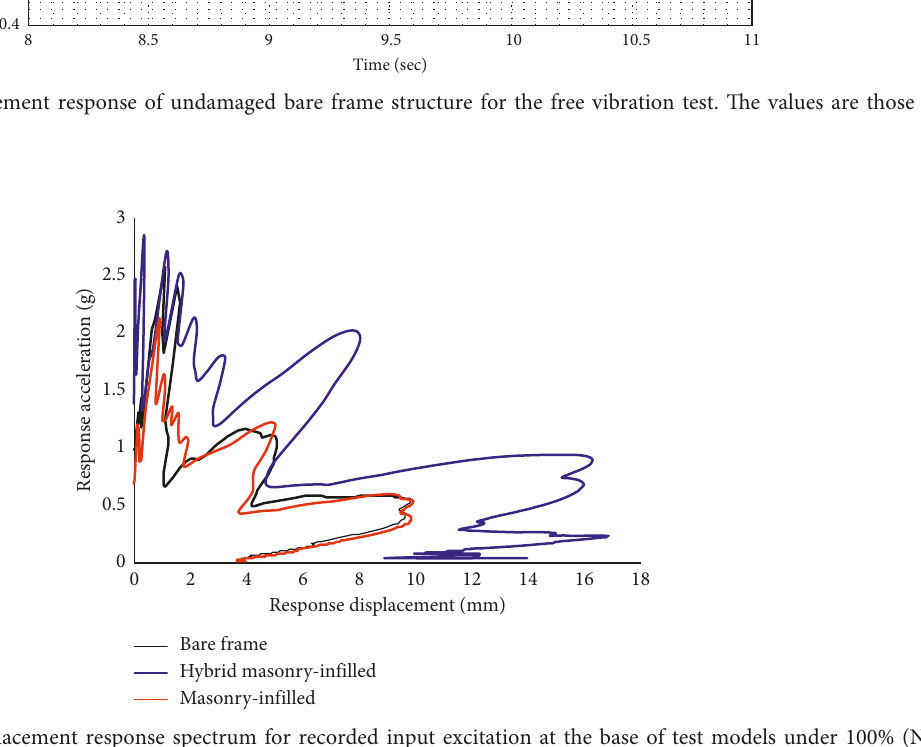
Figure 9: Acceleration-displacement response spectrum for recorded input excitation at the base of test models under 100% (NR1) of earthquake